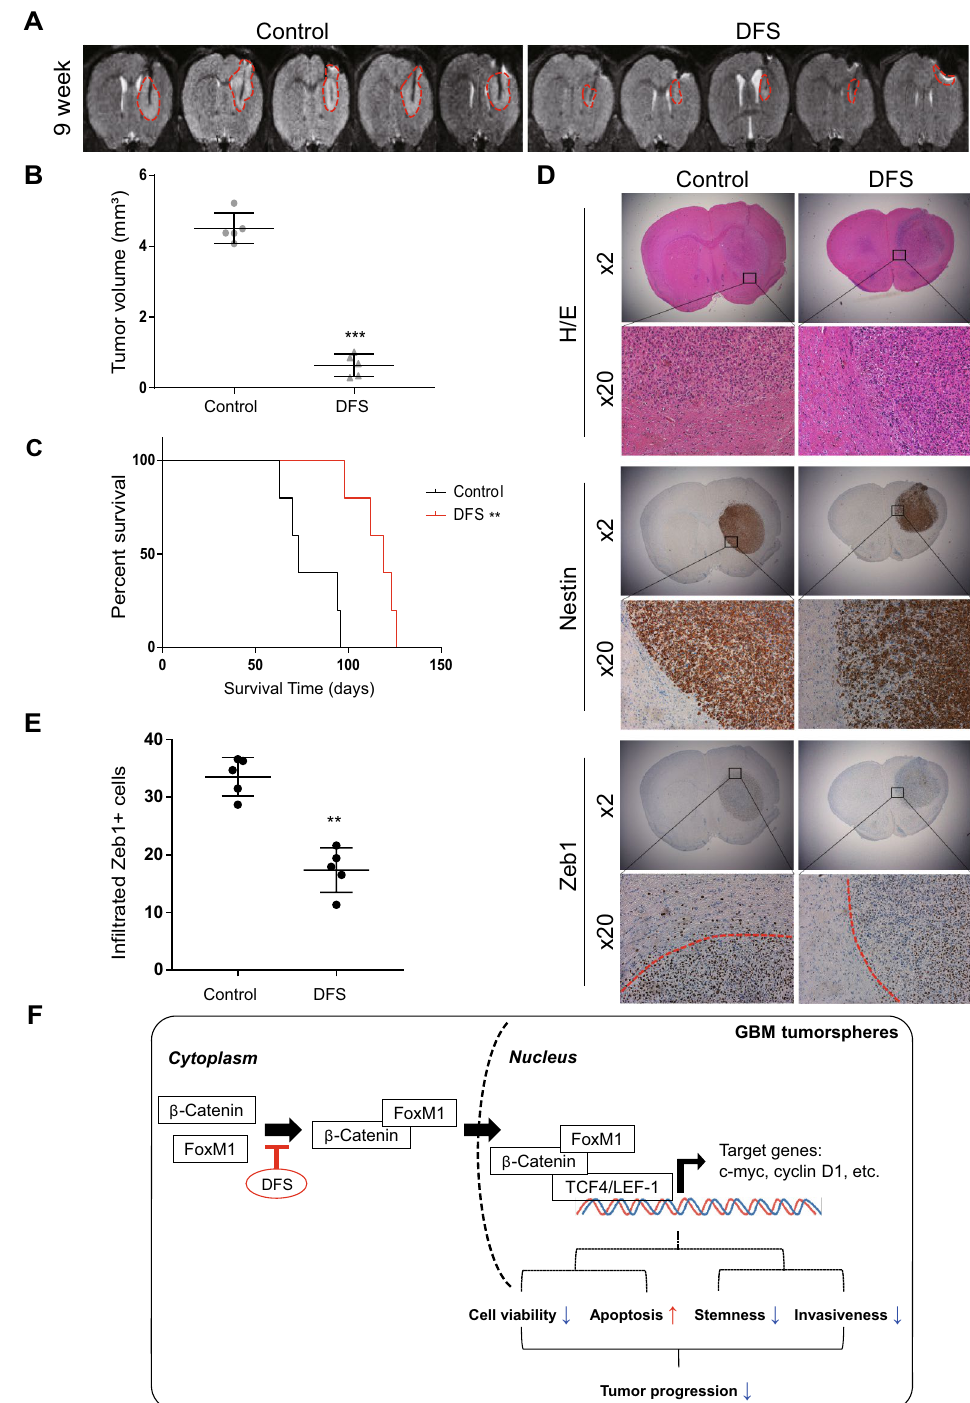
Figure 5. Therapeutic effects of DFS in orthotopic xenograft models. ( A , B ) Tumor volumes of orthotopic xenograft models measured by magnetic resonance imaging (MRI). ( C ) Kaplan–Meier analysis of survival probability of each group of mice, with comparisons by log-rank tests (P < 0.05) with Bonferroni adjustment. ( D , E ) To identify invading cells, section of the brains of killed mice were immunostained for Zeb1. From 10 photos captured for each mouse, the number of infiltrating Zeb+ cells (outside the red line in ( D )) was tallied for each group (means ± SEM; * P < 0.01 compared with control). ( F ) Schematic summary of the